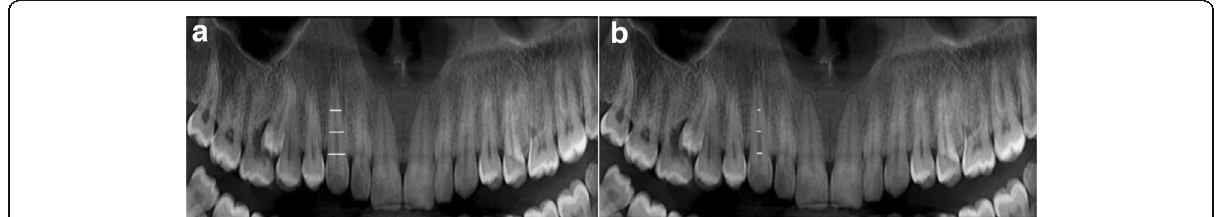
Fig. 4 a , b Pulp/root width ratio at cementoenamel junction level and mid-root level and midpoint between the cementoenamel junction and the mid-root in panoramic-like